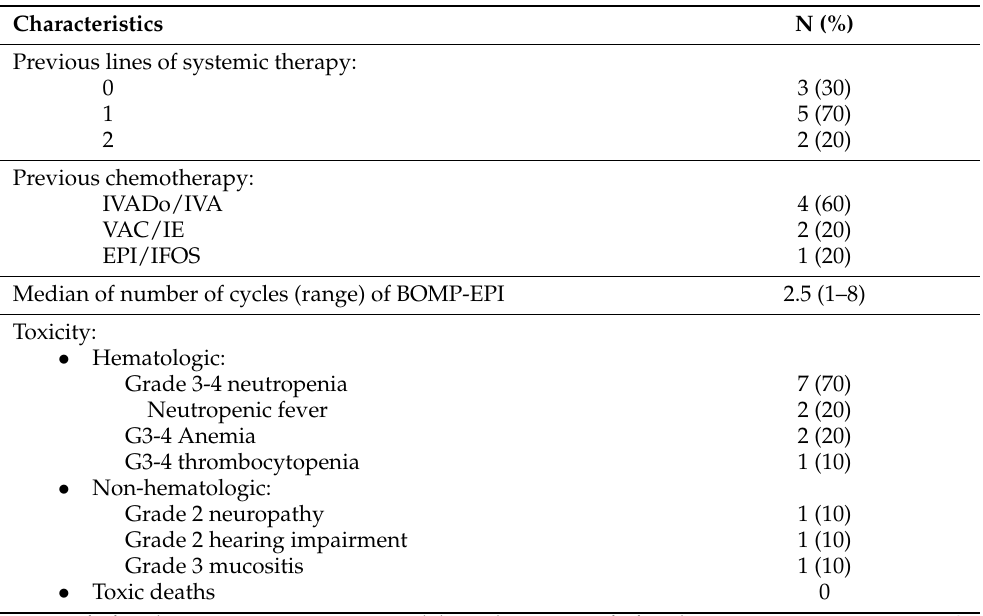
Table 2. Treatment and toxicity.